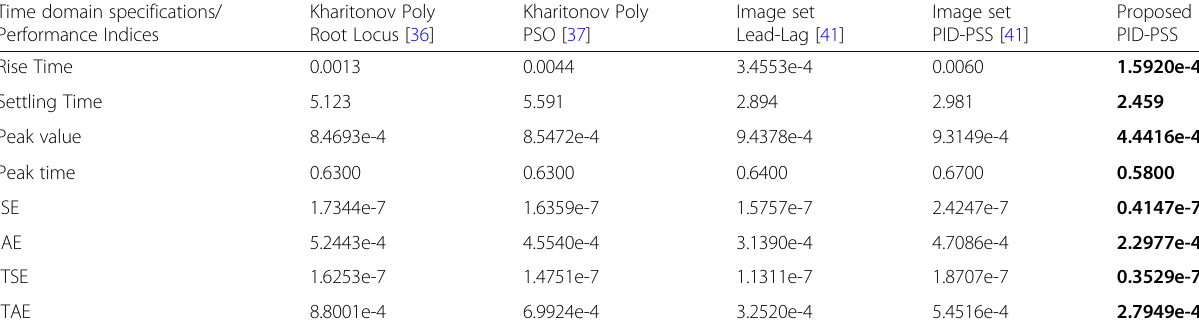
Table 5 Comparision of performance measures between the proposed and existing methods at P = 1 p.u . and Q = -0.4p.u